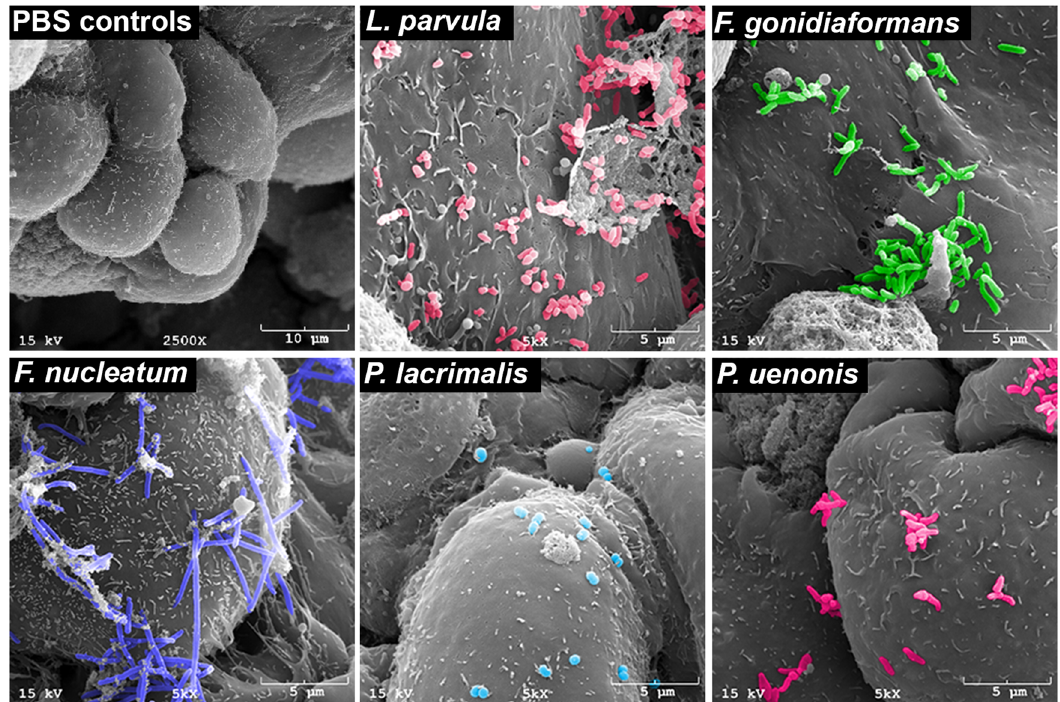
Fig. 1 BVAB colonize 3-D cervical cells. Mock-infected 3-D cervical cells (upper left) demonstrating cobblestone appearance and apical polarity. L. parvula (upper middle) forms small coccobacilli clusters and colonize healthy cells, as well as necrotic cell material (upper right corner of the micrograph). F. gonidiaformans (upper right) colonizes the smooth face of 3-D cervical cells in clusters. F. nucleatum (lower left) forms long, fi lamentous, rugged rod structures that broadly colonize 3-D cervical cells. P. lacrimalis (bottom middle) colonizes 3-D cervical cells mostly as pairs or isolated cocci. P. uenonis (lower right) appears as short bacilli that colonize the surface and crevices of 3-D cervical cells, often in small clusters. All bacteria were processed in PBS and adjusted to an optical density at 600 nm (OD 600 ) of 5.0. Human 3-D cervical cells were infected with bacterial suspensions (20 μ l per 1 × 10 5 epithelial cells) for 4 h under anaerobic conditions and processed for SEM